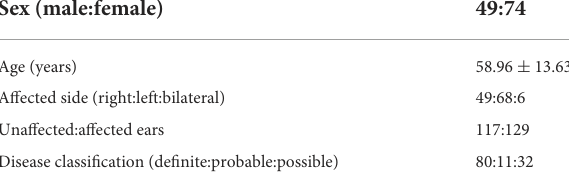
TABLE 1 Demographic characteristics of 123 patients diagnosed with Ménière’s